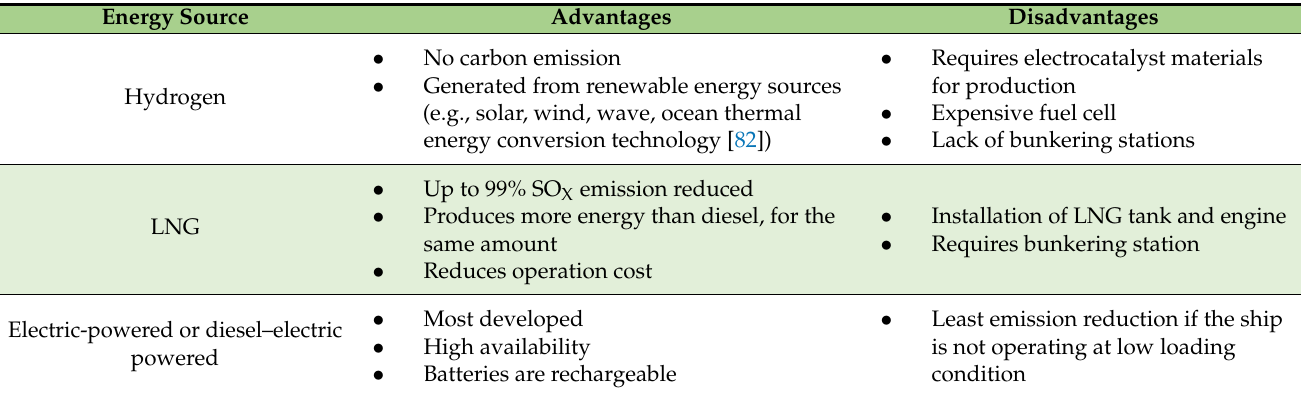
Table 5. Renewable energy sources